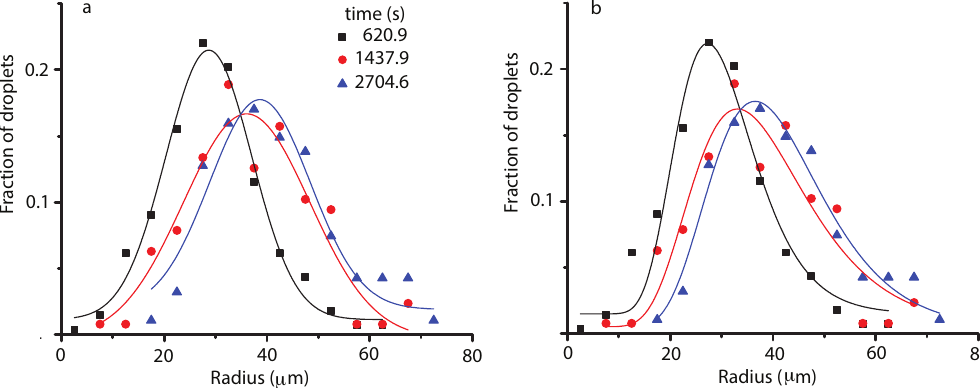
Figure 3. Histograms of microscopic views at successive times 620.9 s (solid squares), 1437.9 s (solid circles), and 2704.6 s (solid triangles). The continuous lines show the corresponding Gauss ( a ) and lognormal ( b ) fits. For image at 620.9 s (solid squares) the center of Gauss distribution is at x cG = (28.7 ± 0.4) µ m and of lognormal is at x cLN = (29.5 ± 0.8) µ m. The corresponding standard deviations are w G = (8.4 ± 0.5) µ m and w LN = (0.28 ± 0.03) µ m. For the snapshot at 1437.9 s (solid circles), x cG = (36.1 ± 1.1) µ m and x cLN = (37.0 ± 1.8) µ m with the standard deviations and w G = (12.3 ± 2.4) µ m and w LN = (0.33 ± 0.06) µ m. For the image at 2704.6 s (solid triangles), x cG = (38.6 ± 1.0) µ m and x cLN = (39.9 ± 1.0) µ m with w G = (9.8 ± 1.5) µ m and w LN = (0.29 ± 0.04) µ